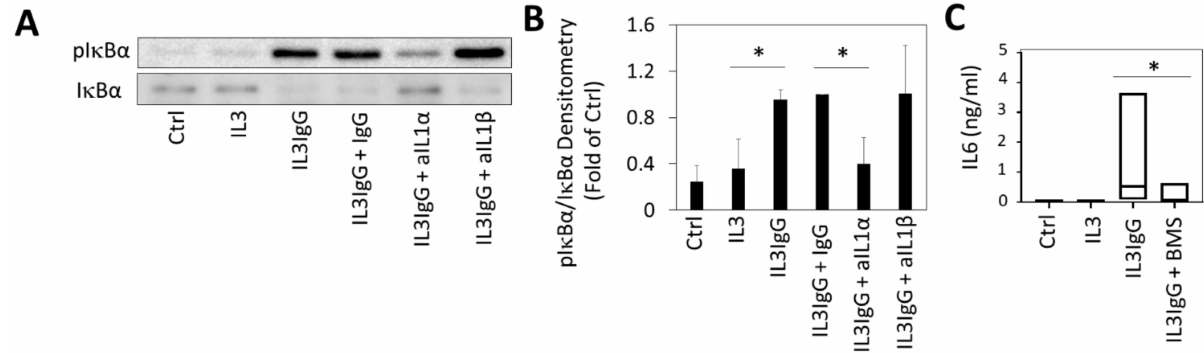
Figure 5. Eosinophil lysis products induce the production of IL6 by human bronchial fibroblasts through the IL1 α -dependent nuclear factor kappa-light-chain-enhancer of activated B cell (NF κ B) signaling mechanism. ( A ) IL3IgG supernatants were incubated for 1 h with either IgG control antibody (1 µ g/mL), IL1 α neutralizing antibody (aIL1 α , 1 µ g/mL) or IL1 β neutralizing antibody (aIL1 β , 1 µ g/mL) prior to stimulation of HBF. HBF were alternatively incubated with basal medium (Ctrl), IL3 or IL3IgG eosinophil supernatants as a control. Thirty minutes after stimulation, HBF protein lysates were obtained and subjected to SDS-PAGE and Western blotting with indicated antibodies. ( B ) Densitometry of Western blots from A. ( n = 3 for all conditions) was done in ImageJ (mean ± sd) and analyzed by unpaired Student’s t -test with Bonferroni correction to determine statistically significant differences (* p < 0.025). ( C ) HBF were treated with I κ B kinase inhibitor (10 µ M BMS-345541 (BMS)) or vehicle (dimethyl sulfoxide (DMSO)) prior to stimulation with eosinophil supernatants for 24 h. HBF supernatants were collected ( n = 7 for all conditions) and levels of IL6 were determined via ELISA. Paired Student’s t -test was used to test for statistically significant differences (* p <